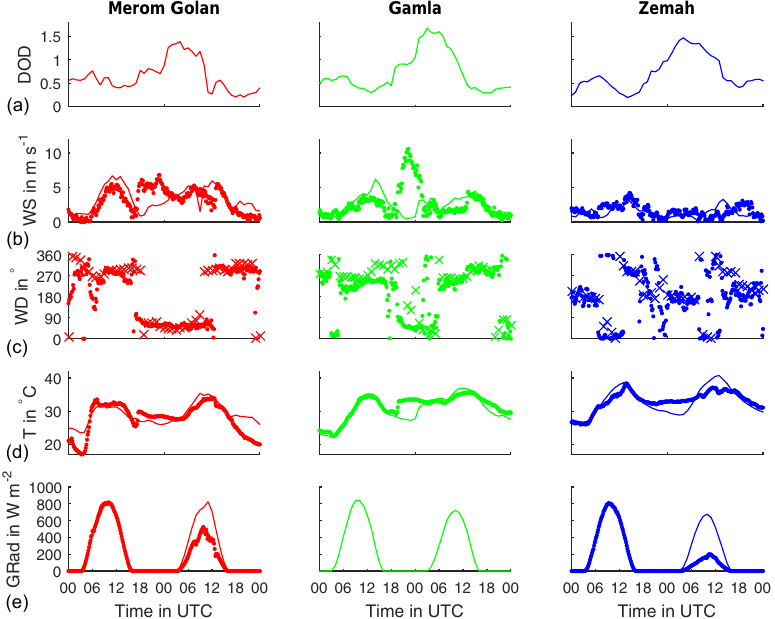
Figure 11. Observations and model results for three stations in the Golan Heights for 7 and 8 September. Points denote observations and solid lines/crosses model results. From top to bottom: (a) modelled DOD; (b) wind speed (WS); (c) wind direction (WD); (c) 2m surface temperature; (e) global radiation